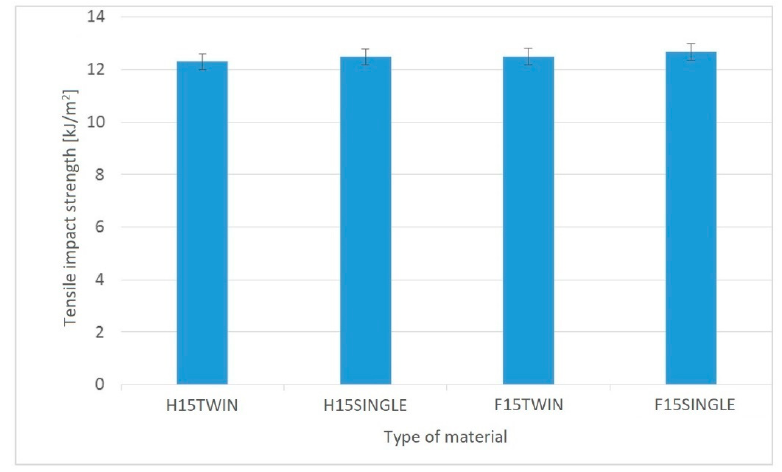
Figure 9. Impact tensile strength of PHBV biocomposites produced with single- and twin-screw extrusion.